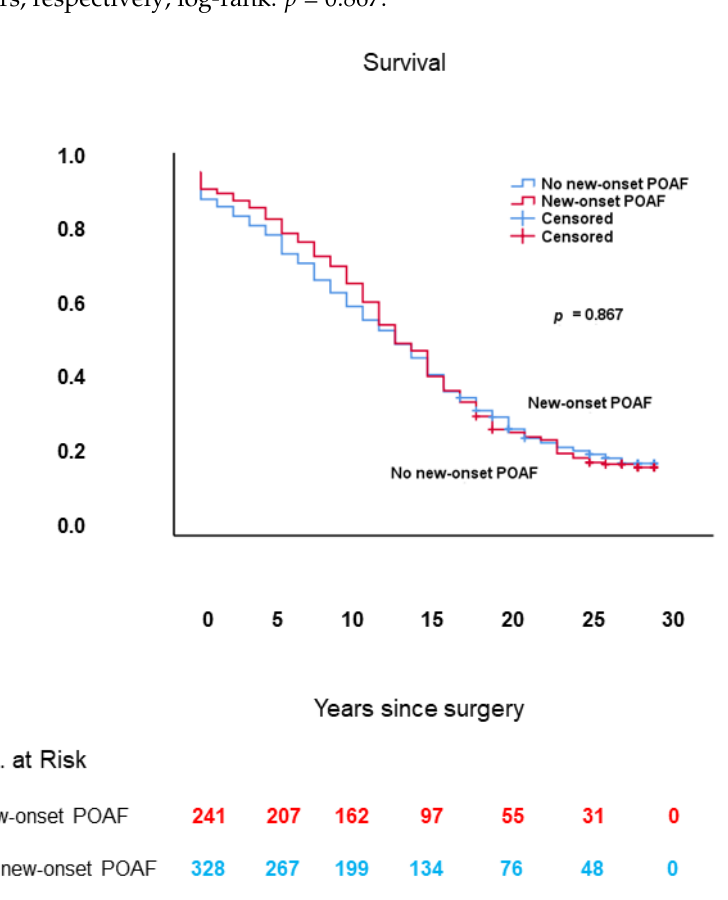
Figure 10. Kaplan–Meier survival curves, from date of surgery, of patients with new-onset POAF vs. those without. POAF: postoperative atrial fibrillation.